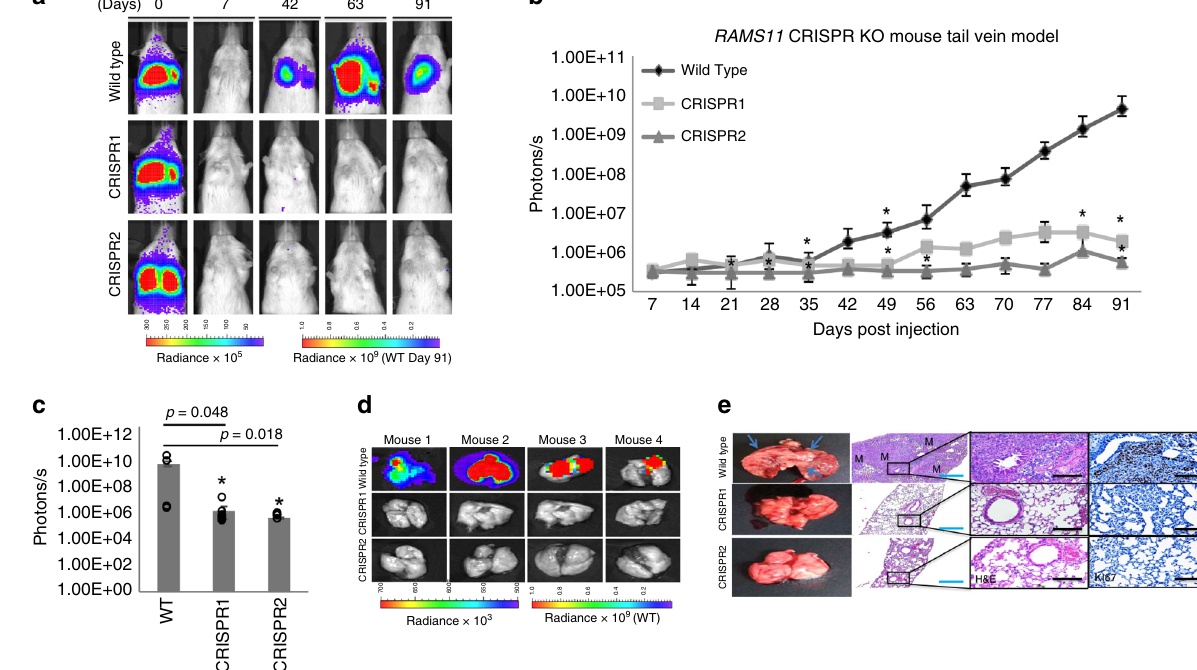
Fig. 4 RAMS11 induces lung metastasis via tail vein mouse model. a Representative mice and b quanti fi cation showing no lung metastasis in RAMS11 CRISPR KO cell-injected mouse by BLI. Day 28 CRISPR2 p = 0.04, day 35 CRISPR1 p = 0.02 CRISPR2 p = 0.013, day 49 CRISPR1 p = 0.02 CRISPR2 p = 0.01 day 84 CRISPR1 p = 0.05 CRISPR2 p = 0.03, day 91 CRISPR1 p = 0.04 CRISPR2 p = 0.01. c , d Day 91 ex vivo mouse lungs show RAMS11 CRISPR KO cell-injected mice have decreased lung metastasis by BLI. e Hematoxylin and eosin stain showing metastasis (M) and Ki67 stain. Three independent tissues were stained per group. Blue bar = 1 mM, black bar = 25 µ M. Data shown as mean ± SEM and analyzed by two-tailed paired t -test, with n = 12 per group repeated two times. * p < 0.05. Source data are provided as a Source Data drug sensitivity to irinotecan (siRNA1 fold > 3.17 and siRNA2 fold > 11.8, Supplementary Fig 5f). (Fig. 6a, b). To further support our observation that RAMS11